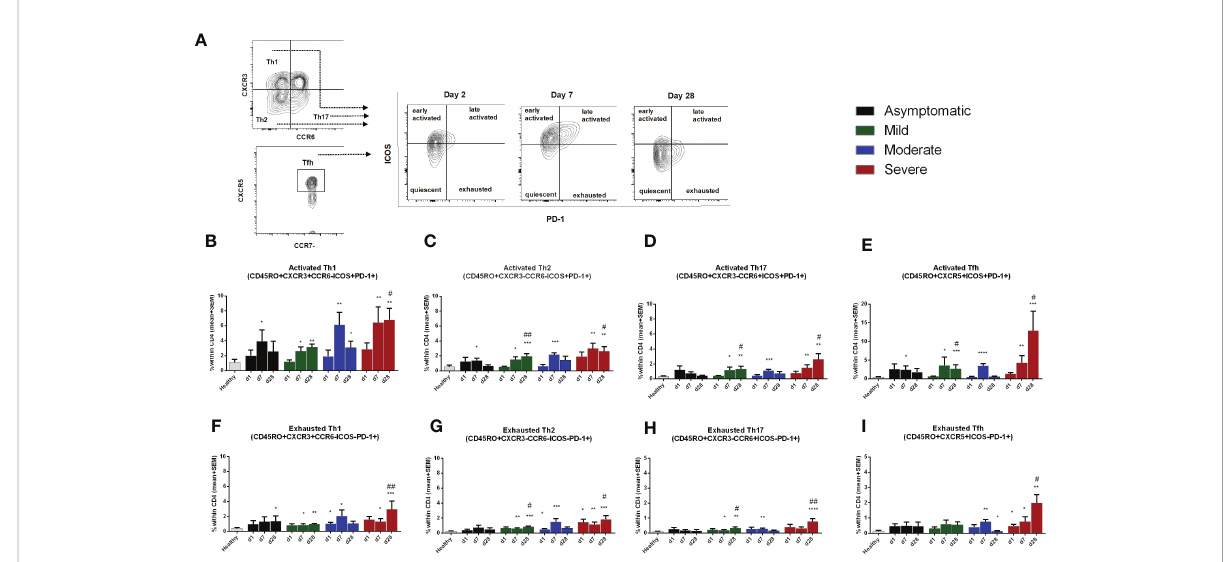
FIGURE 5 Frequencies of activated and exhausted Th cells in patients with differing severity of COVID-19 infection compared to healthy controls. (A) Representative images of different stages of Th cell activation analyzed using fl ow cytometry. Frequencies of ICOS+PD-1+ late activated memory (B) , Th1 (C) . Th2 (D) . Th17. and (E) Tfh, as well as frequencies of ICOS-PD-1+ exhausted memory (F) , Th1 (G) , Th2 (H) , Th17, and (I) Tfh populations within CD4+ cells in PBMCs isolated from healthy adults (n =1 0) and patients with asymptomatic, mild, moderate and severe COVID-19 on day 1 (n = 6-7 per group), 7 (n = 10-12 per group) and 30 (n = 8-10 per group). Bars indicate mean+SEM values. Asterisks (*) represent signi fi cant differences between healthy controls vs. asymptomatic, mild, moderate and severe patients and hash (#) represent signi fi cant differences between asymptomatic patients vs. mild, moderate and severe patients on different days. Statistical analysis was performed between healthy controls and patients using Mann-Whitney U test. *P < 0.05, **P < 0.01, ***P <